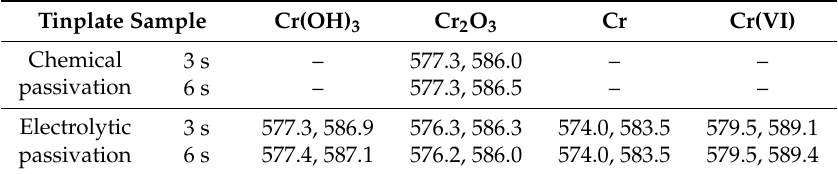
Table 7. Atomic percentage (at.%) of the composition of the passivation films obtained through different processes.